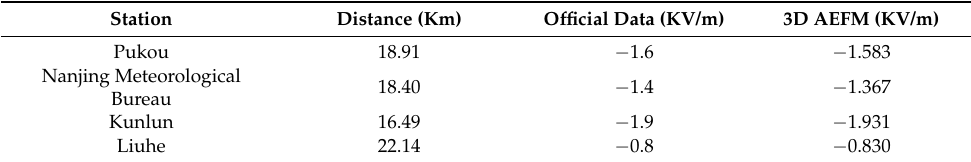
Table 2. Comparisons between official data and 3D AEFM (the three-dimensional electric field meter)